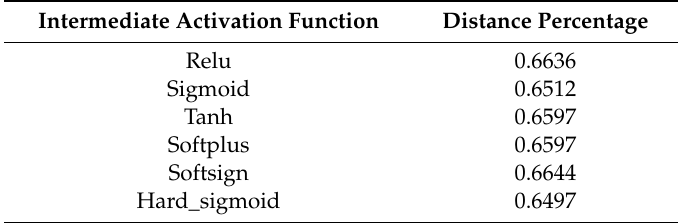
Table 4. The distance percentage of di ff erent intermediate activation